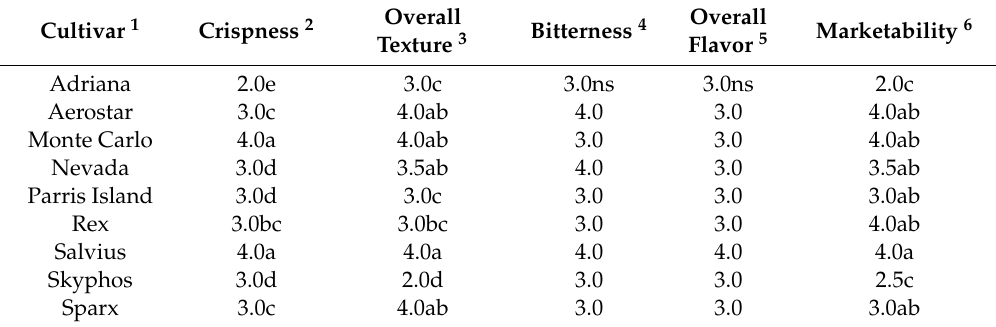
Table 4. Di ff erences in five sensory criteria between nine lettuce cultivars tasted by 50 untrained panelists in a sensory evaluation.